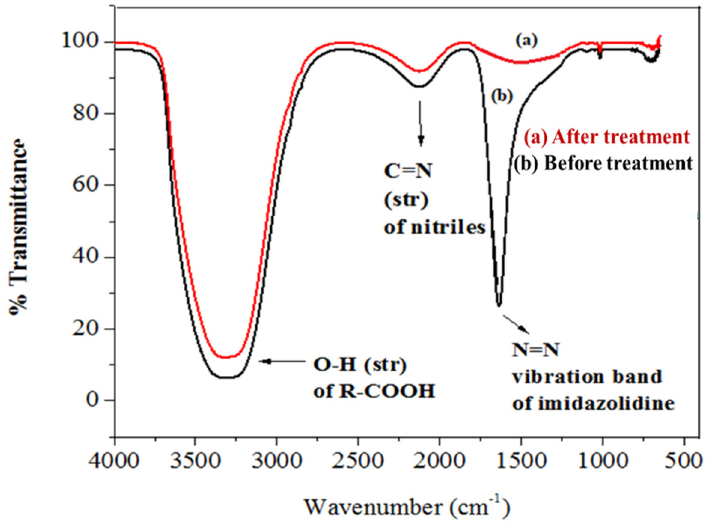
Figure 13. FTIR spectrum of the ( a ) sample of imidacloprid treated with basic prewetted (pH 11) and ( b ) as-fabricated untreated imidacloprid sample.